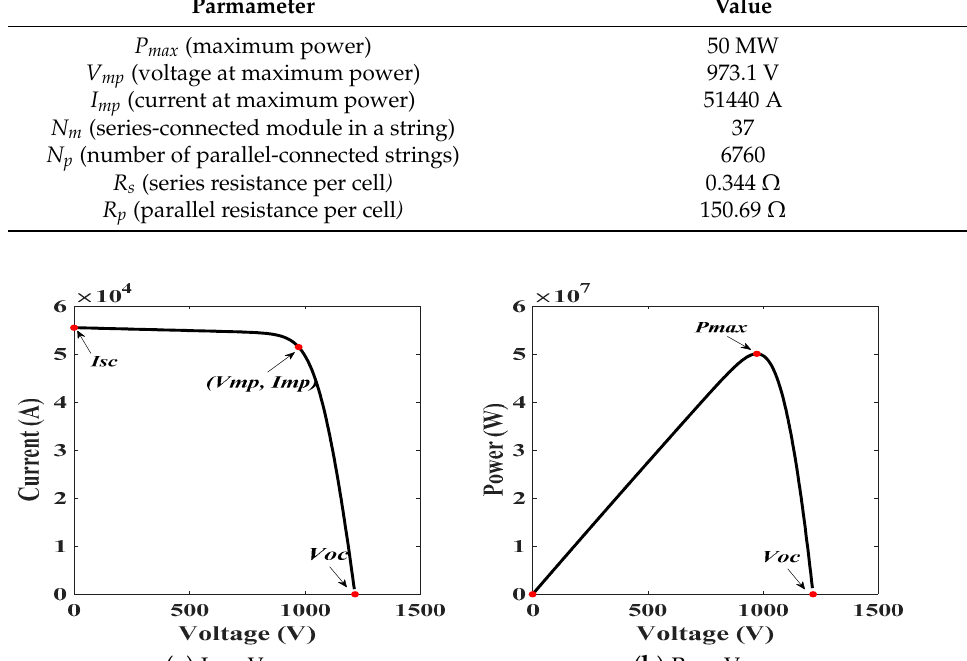
Figure 3. Characteristic curves of a 50 MW PV station.